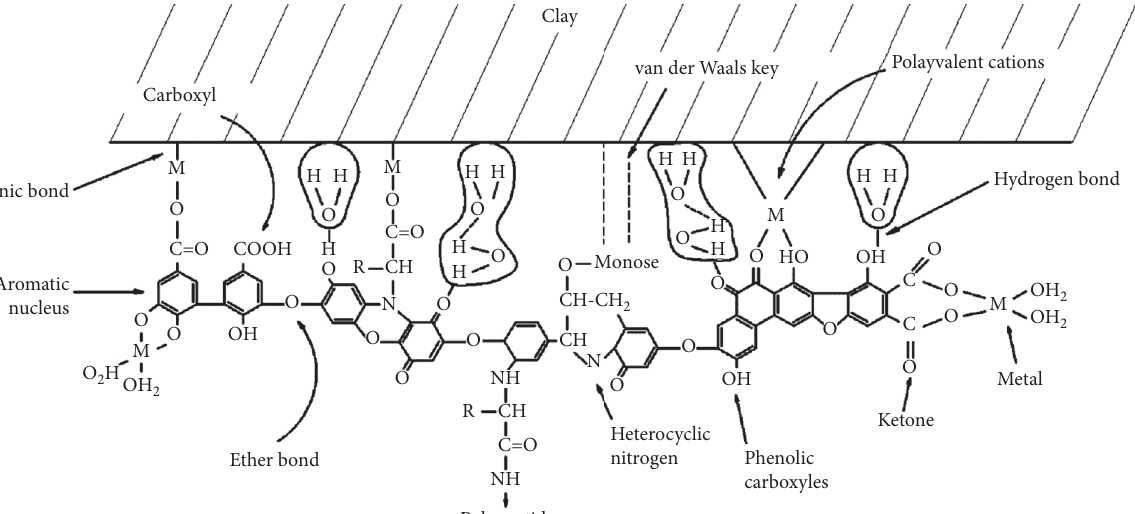
Figure 11: Clay mineral-humus complex [37].